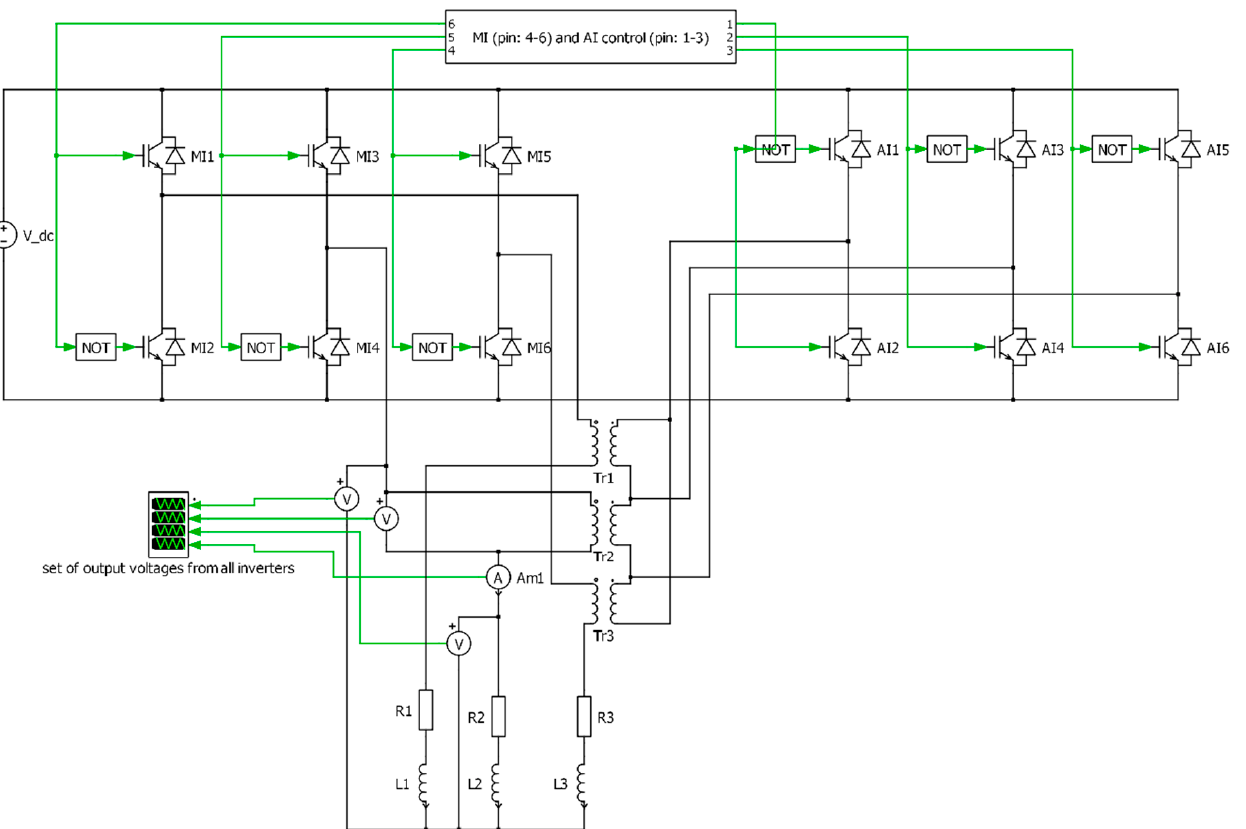
Figure 4. The model of an OVT inverter with a summing circuit in the form of transformers and a resistive load created using the PLECS program. Table 1. Electrical load parameters during the